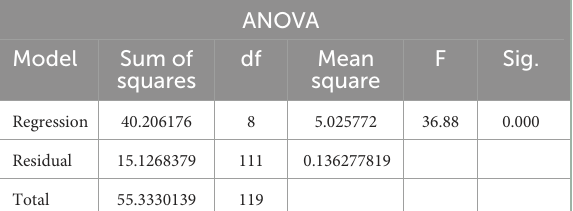
TABLE 6 ANOVA test